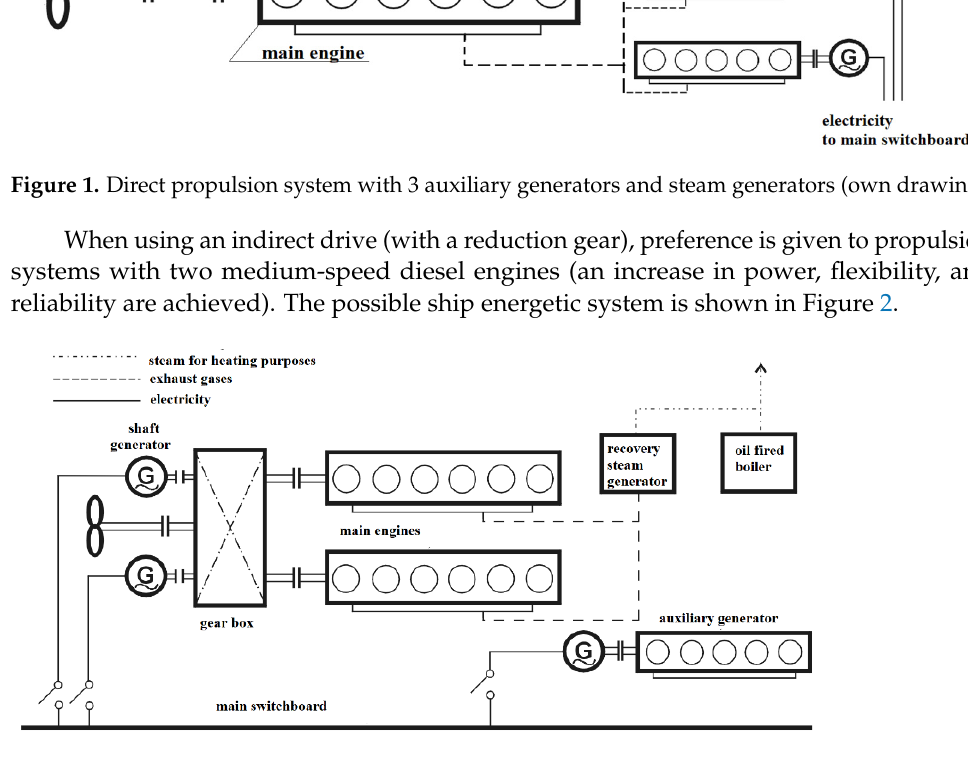
Figure 2. Indirect propulsion system with two shaft generators, one auxiliary genset and steam generator (own drawing).